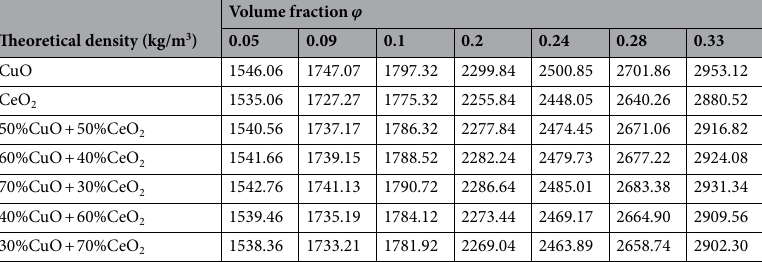
Table 9. Theoretical density of the nanorefrigerant.